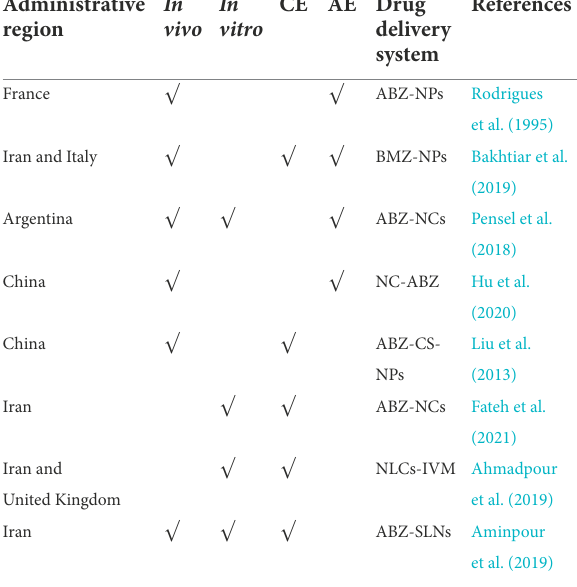
TABLE 2 Nano drug delivery system of Albendazole. Administrative region